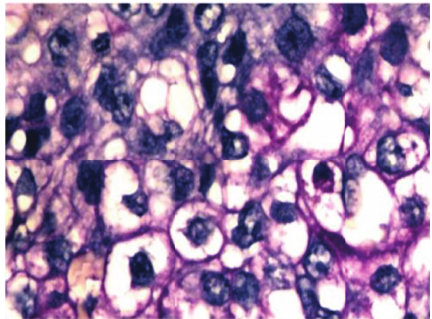
Figure 3: Some neoplastic epithelial cells with clear cytoplasm retain PAS positivity after diastase digestion